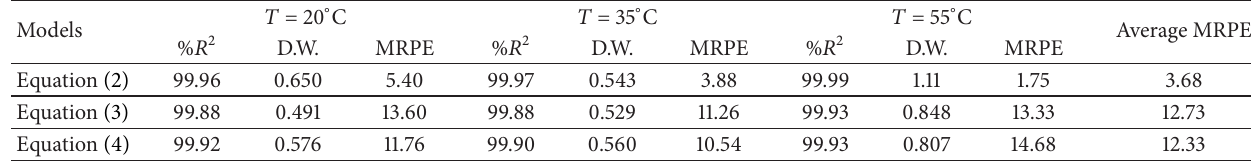
Table 2: Models fitting results for citric acid data.